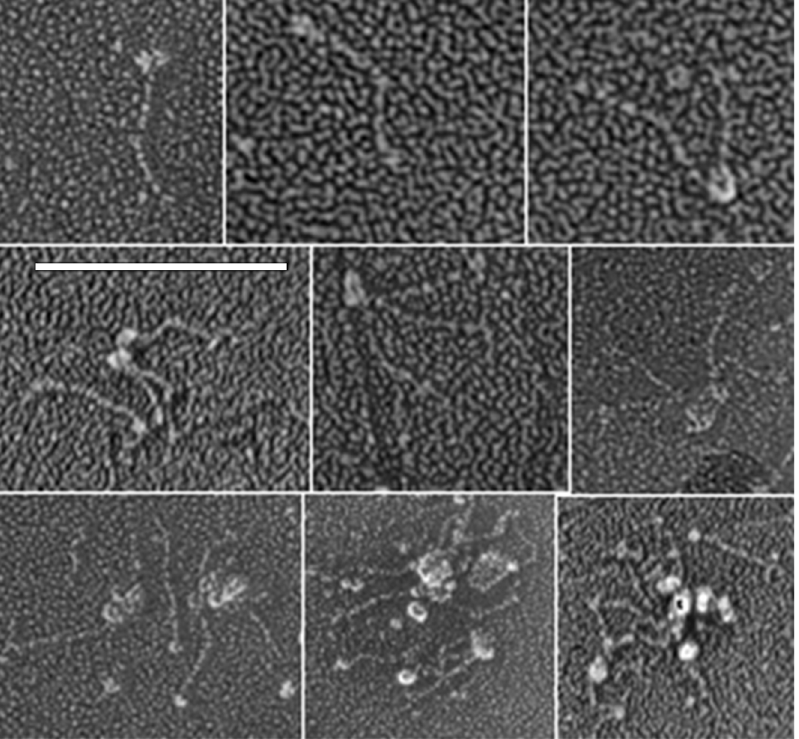
Figure 1. Images of rmOtolin-1 molecules visualized by electron microscopy after rotary shadowing. rmOtolin-1 molecules were adsorbed on mica and visualized by electron microscopy after rapid freezing, freeze-drying, and rotary shadowing. The interaction of the C1q domains is evident and similar to the interactions observed for collagen X by Kwan, et al. [20]. Scale Bar, 100 nm.